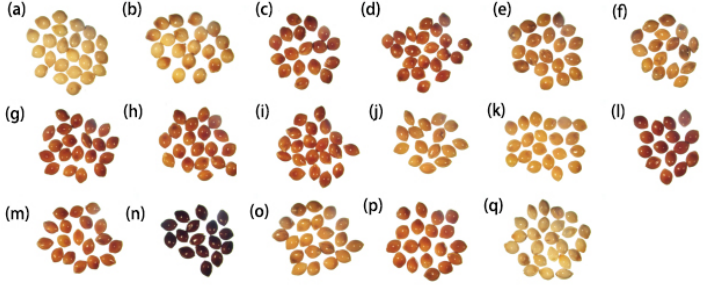
Figure 11. External seed morphological characteristics of the 17 broomcorn millet populations con ‐ sidered in this study: ( a ) Jinmi 4; ( b ) Jinmi 9; ( c ) Longmi 7; ( d ) Longmi 8; ( e ) Neimi 5; ( f ) Neimi 6; ( g )